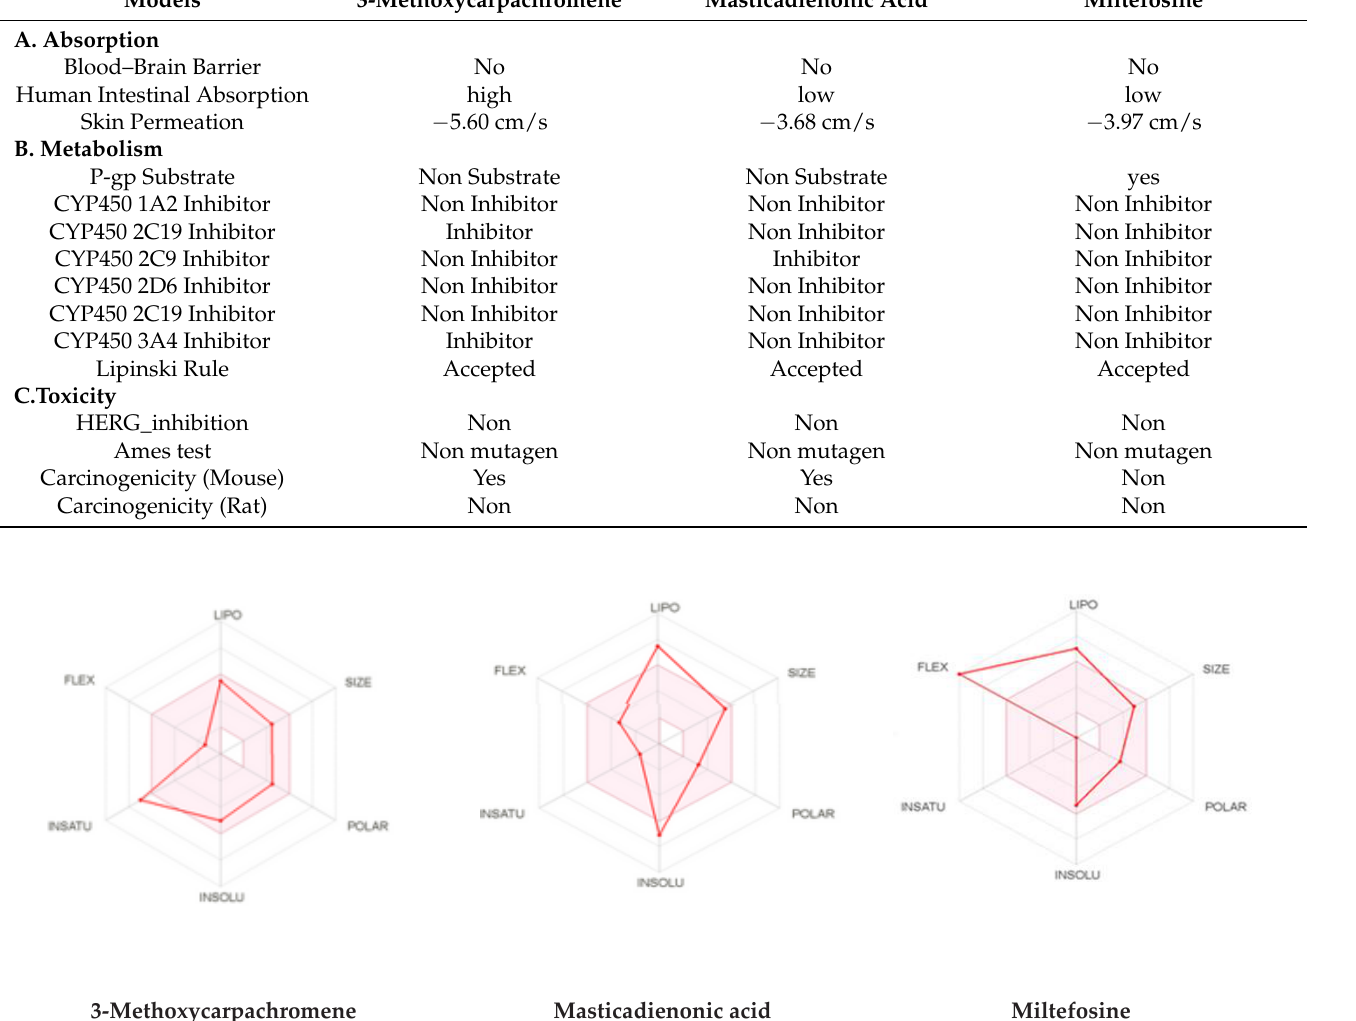
Figure 3. Summary of the pharmacokinetic properties of the studied complexes. Table 4. ADMET profiling enlisting absorption-, metabolism-, and toxicity-related drug-like parameters of the two se- lected ligands.